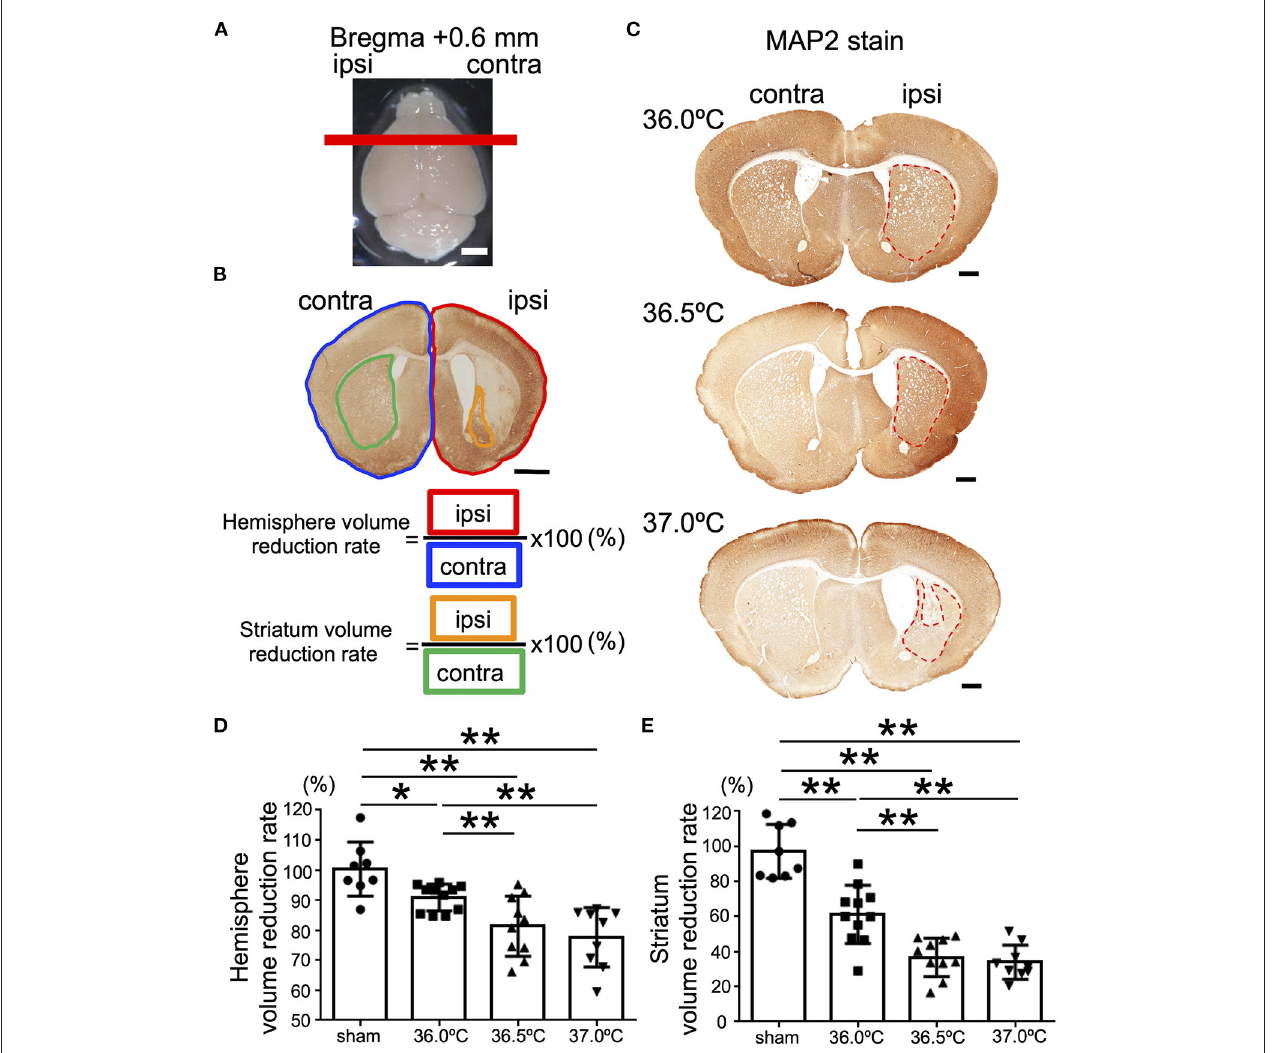
FIGURE 2 | Differences in cerebral volume loss at striatal position due to ambient temperature in HIE mice. (A) The red line shows the bregma + 0.6mm, which indicates the position where the brain was cut. Scale bar = 2mm. (B) Calculation method of cerebral volume loss. After MAP2 stain, the whole hemisphere volume reduction rate was calculated by dividing the whole ipsilateral hemisphere (area surrounded by red line) by the whole contralateral hemisphere (area surrounded by blue line). The volume reduction rate of striatum was calculated by dividing the ipsilateral striatum (area surrounded by orange line) by the contralateral striatum (area surrounded by green line). Scale bar = 500 µ m. (C) MAP2 staining at striatal position 14 days after hypoxia at temperatures of 36.0, 36.5, or 37.0 ◦ C. Red dotted line showing MAP2-positive staining areas. Scale bars = 500 µ m. (D,E) The volume reduction rate at the striatal position in the hemisphere (D) or striatum (E) (sham, •, n = 8; 36.0 ◦ C, (cid:4) , n = 11; 36.5 ◦ C, N , n = 10; 37.0 ◦ C, H , n = 9). * p < 0.05, ** p < 0.01. Error bars show means + SD. Ipsi, ipsilateral; contra,